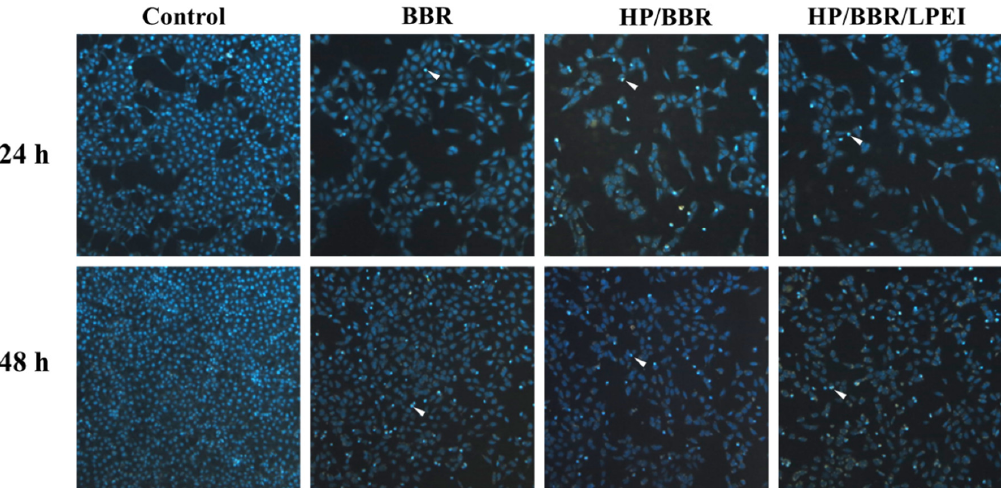
Figure 6. BBR and BBR NPs (HP/BBR and HP/BBR/LPEI NPs) induce nuclear chromatin